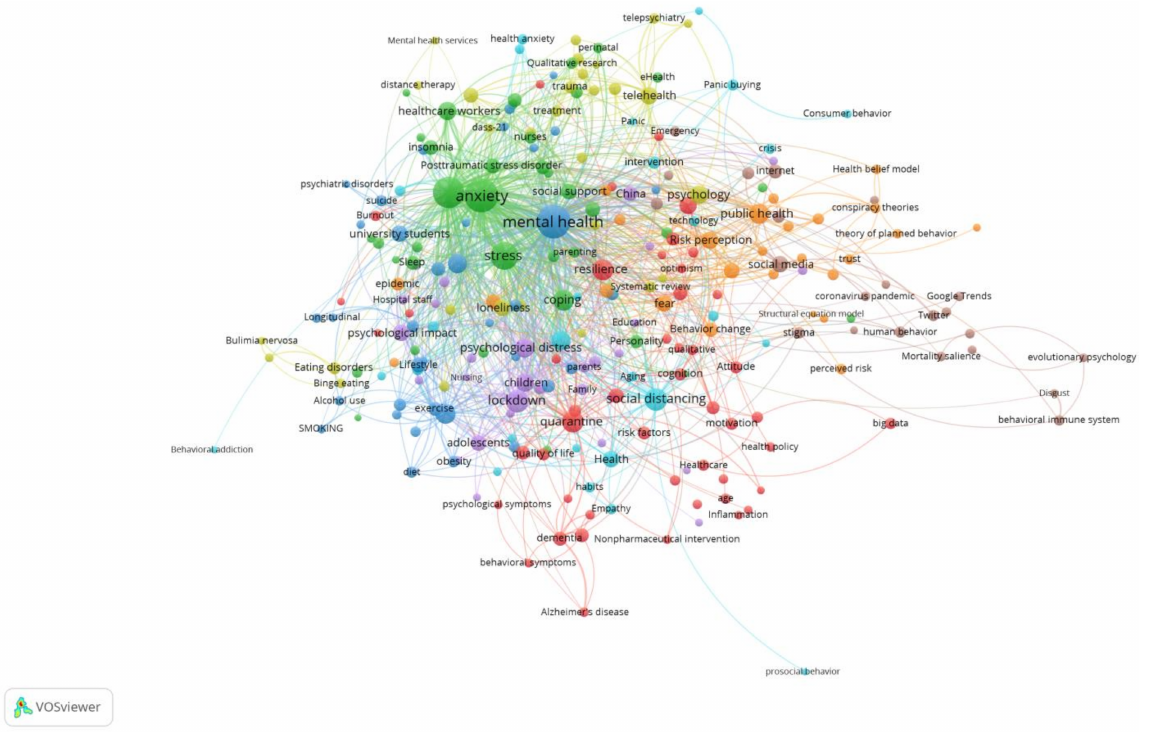
Figure 1. Network map of keywords visualization for publishing